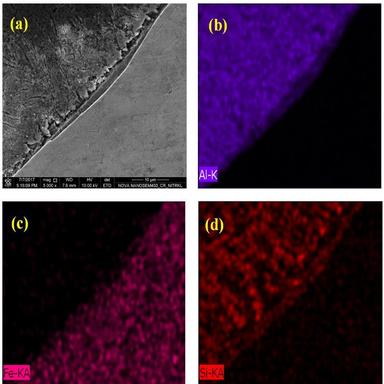
EDS Elemental mapping of laser brazed joint (4 kW power).